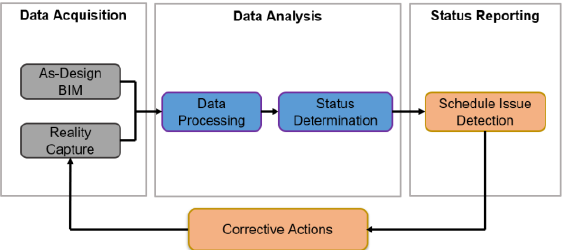
Figure 1. The modules of proposed system.